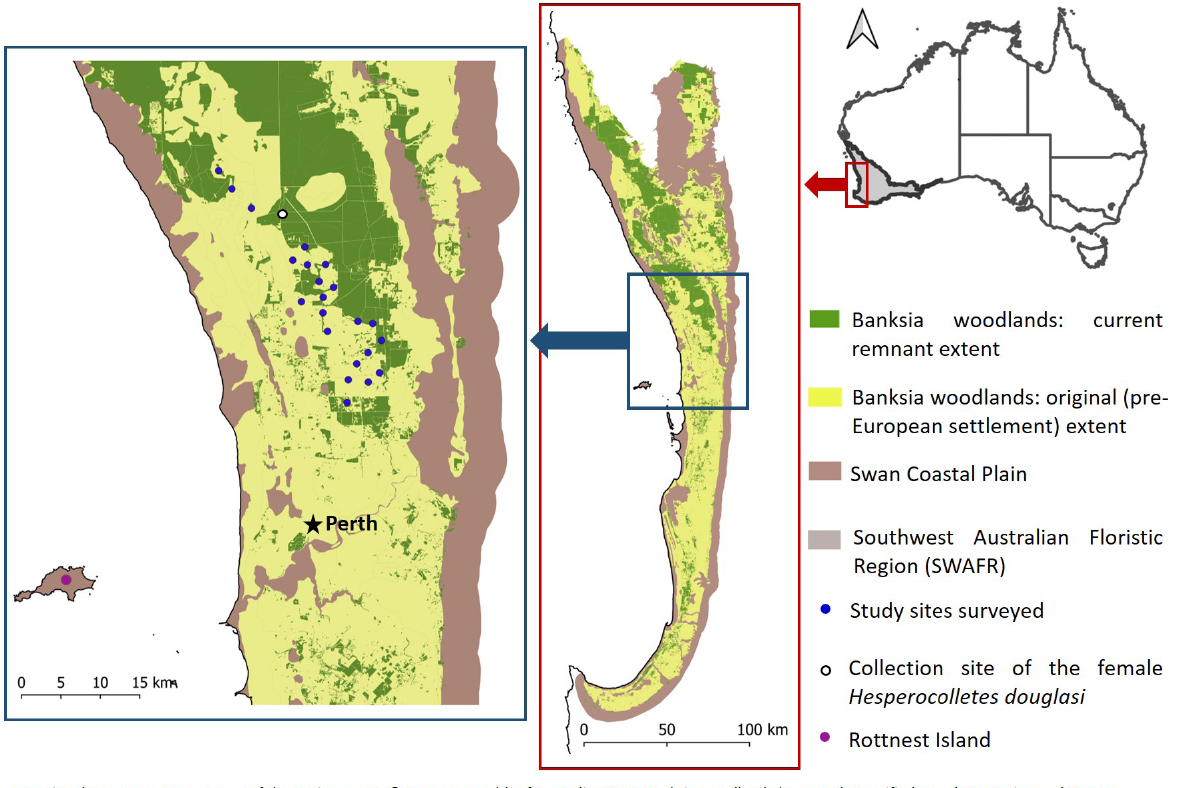
Figure 1. Twenty-three study sites surveyed and collection site of the female of Hesperocolletes douglasi in the Gnangara-Moore River State Forest, ca. 41km north of Perth, Western Australia, Australia; Rottnest Island, the type collection site; the original (pre-European settlement) and current extent of Banksia woodlands in the Swan Coastal Plain in the Southwest Australian Floristic